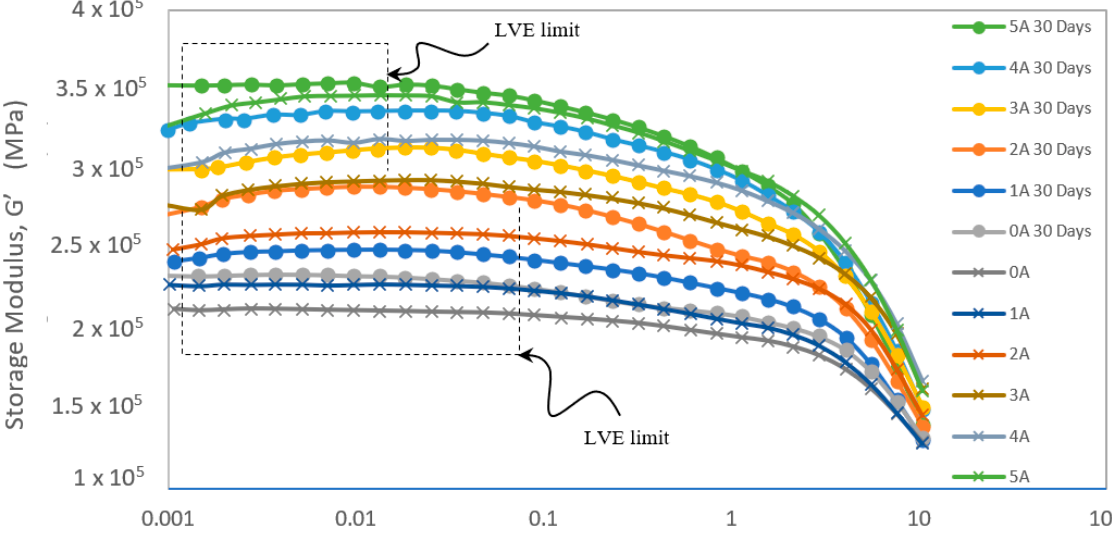
Figure 7. Magnetorheological elastomer storage modulus evaluation before and after 30 days dura- bility under natural weathering conditions.